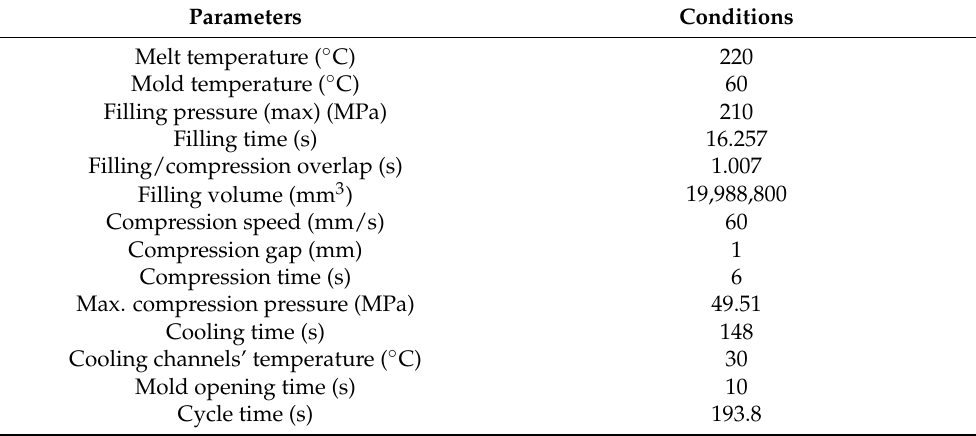
Table 1. Injection compression molding parameters of TAISOX ® HDPE 8041.